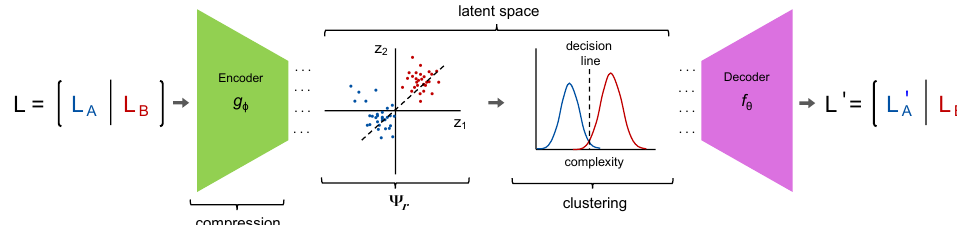
Figure 1. Compression by a lossless encoder g φ removes redundancy. The observations in L are then represented in the latent space defined by z and clustered according to their normalized compression distance [13]: a tractable approximation of the algorithmic complexity (image inspiration from